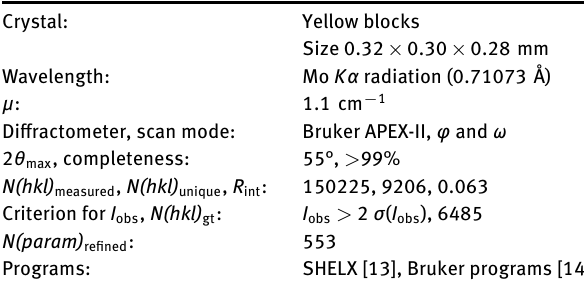
Table 1: Data collection and